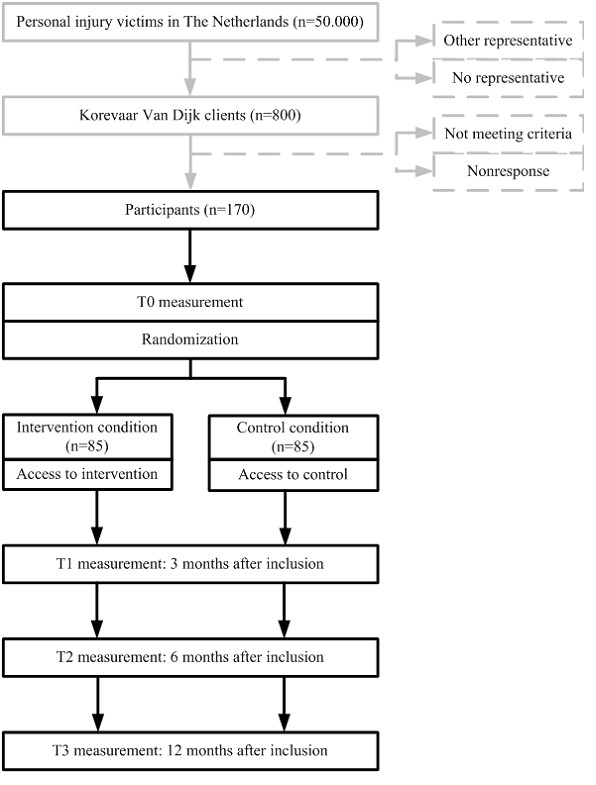
Study procedure.